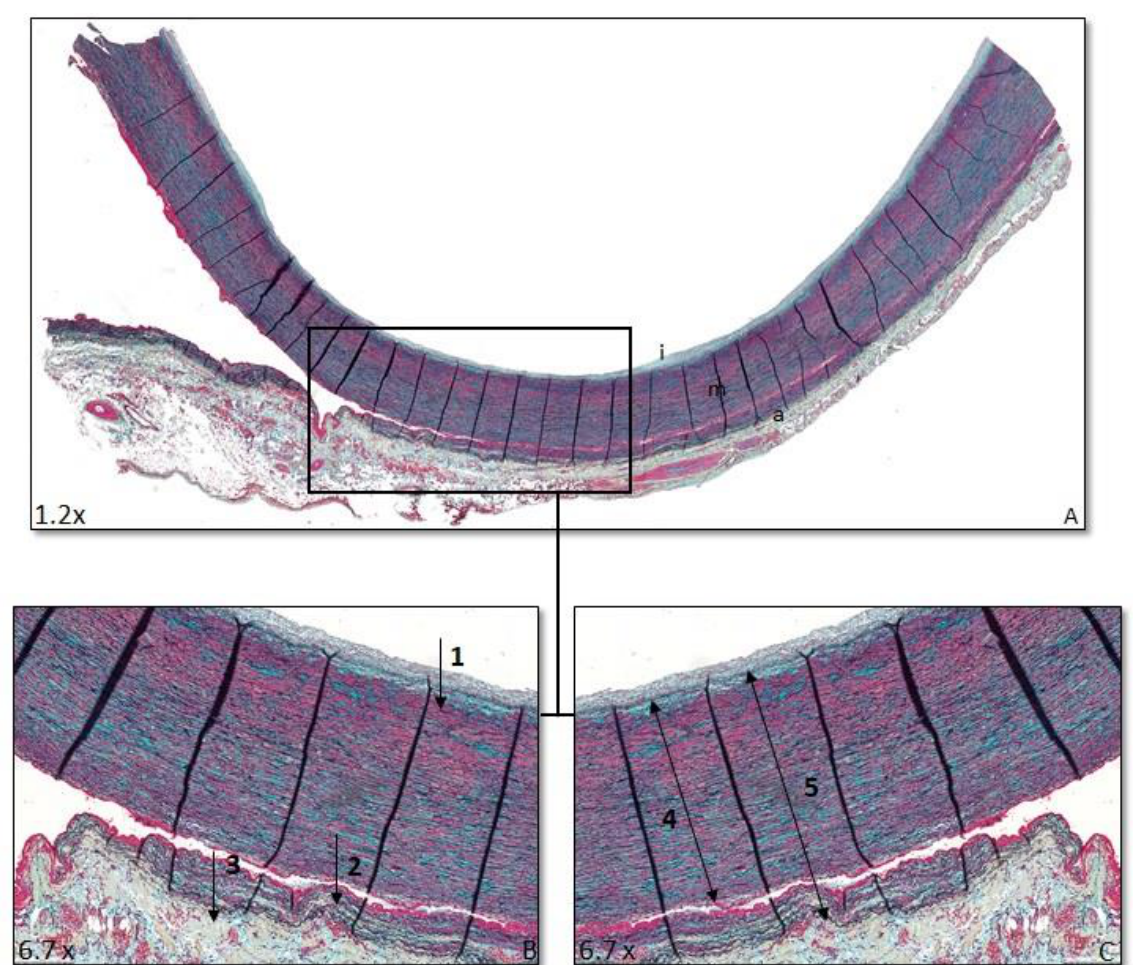
Figure 1. Ratio dissection plane. Transverse histologic sections of the ascending aorta 4 µm stained with MOVAT penta- chrome staining. ( A ) Overview ascending aorta I = intima, m = media, a = adventitia. ( B ) 1: Lamina elastica interna (LEI), 2: dissection plane (DP), and 3: lamina elastica externa (LEE). ( C ) 4: Distance between LEI and DP, 5: distance between LEI and LEE. Ratio dissection plane is defined as distance 4 divided by distance 5.